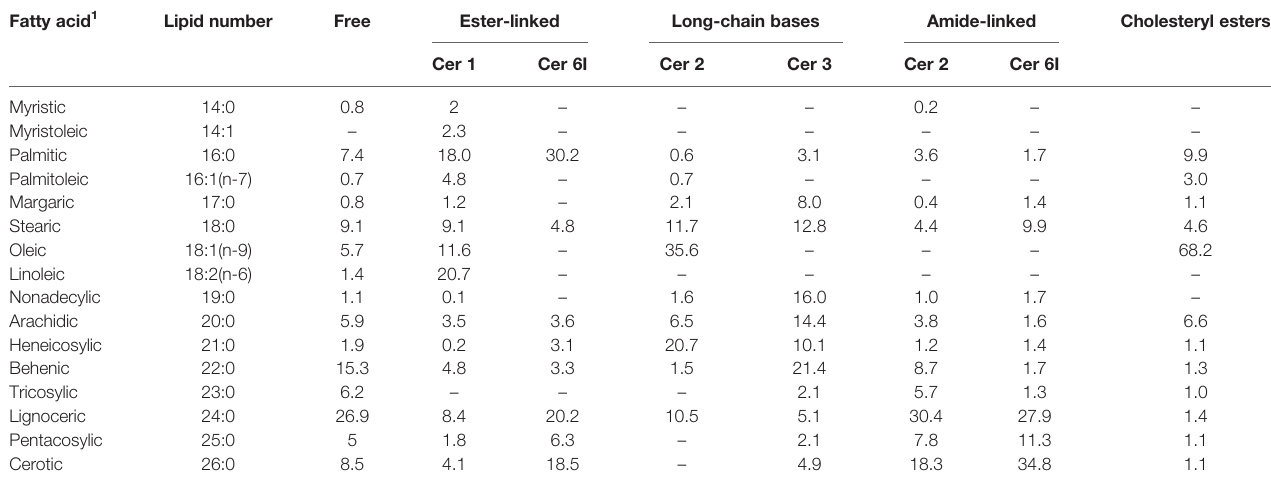
TABLE 3 | Compositions of skin bound fatty acids by various lipid class (%). Fatty acid 1 Lipid